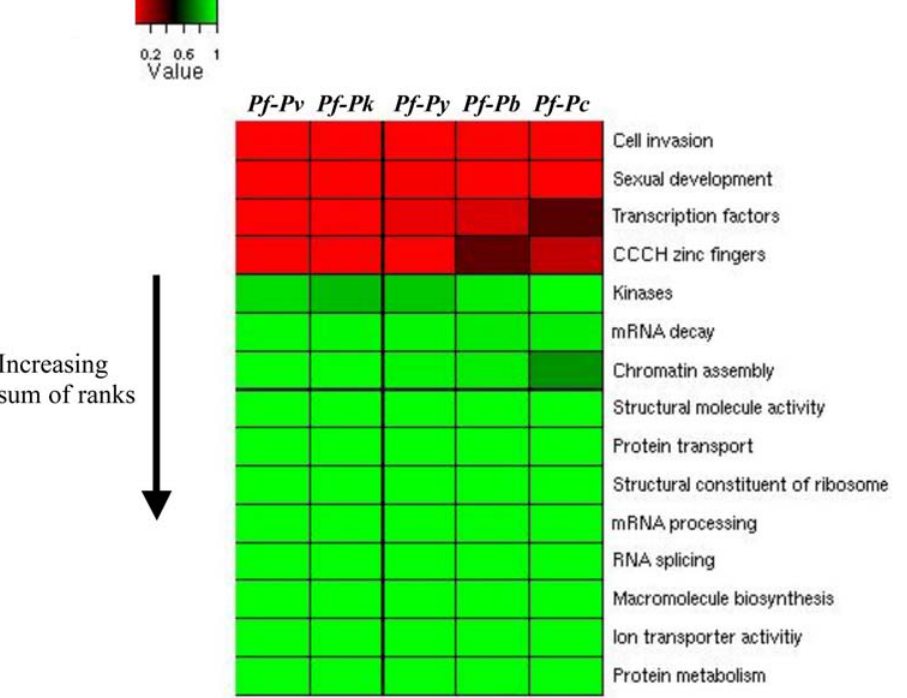
Figure1. Genegroups arranged bylevel of constraint oncodingregions. Cell invasion,sexualdevelopment, transcription factorsand CCCH zinc fingers havelessconstrained protein codingregionsthanthe other groups ofgenes considered. Elements ofthe heatmap represent the p-values resulting from testing the alternative hypothesis that proteins in a particular group rank among the least constrained proteins (higher dN/dS) among all proteins with orthologs in 2 particular species. The 15 groups were ranked from the least constrained to the most constrained in each of the 5 cross-species comparisons and the sum of the ranks was determined (Table S2) and used to order the protein groups in the heatmap. Pf-Pv, Pf-Pk, Pf-Py, Pf-Pb and Pf-Pc represent results from comparisons between P. falciparum and P. vivax, P. knowlesi, P. yoelii, P. berghei and P. chabaudii